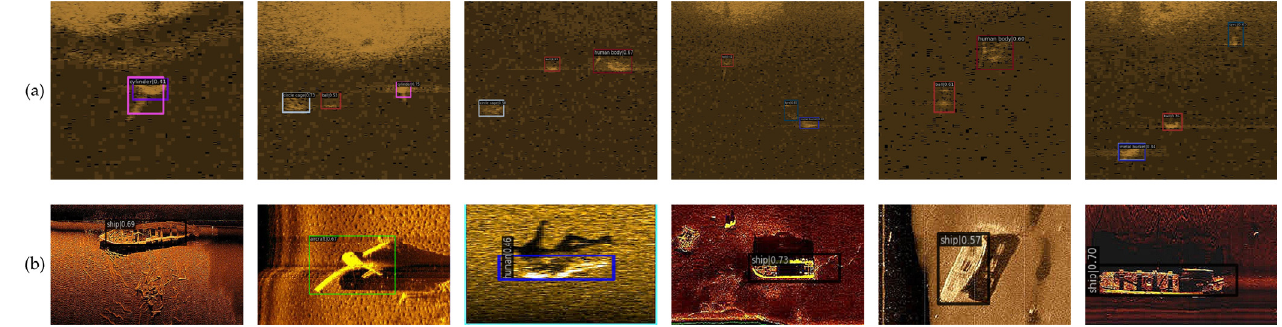
Figure 11. Test Results of DP-ViT on Sonar Images with Few Samples. ( a ) Forward-Look Sonar Dataset ( b ) Side-Scan Sonar Dataset. Table 6. Test results of DP-ViT on Sonar Images with Few Samples (FLS Dataset: Forward-Look Sonar Dataset, SSS Dataset: Side-Scan Sonar Dataset).